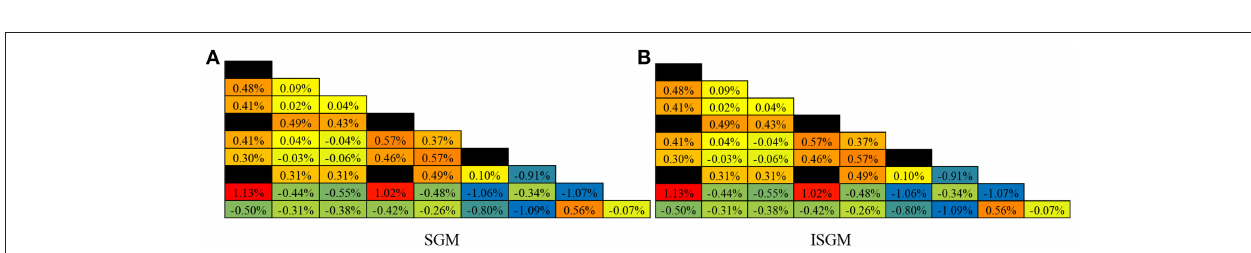
Frontiers in Energy Research |